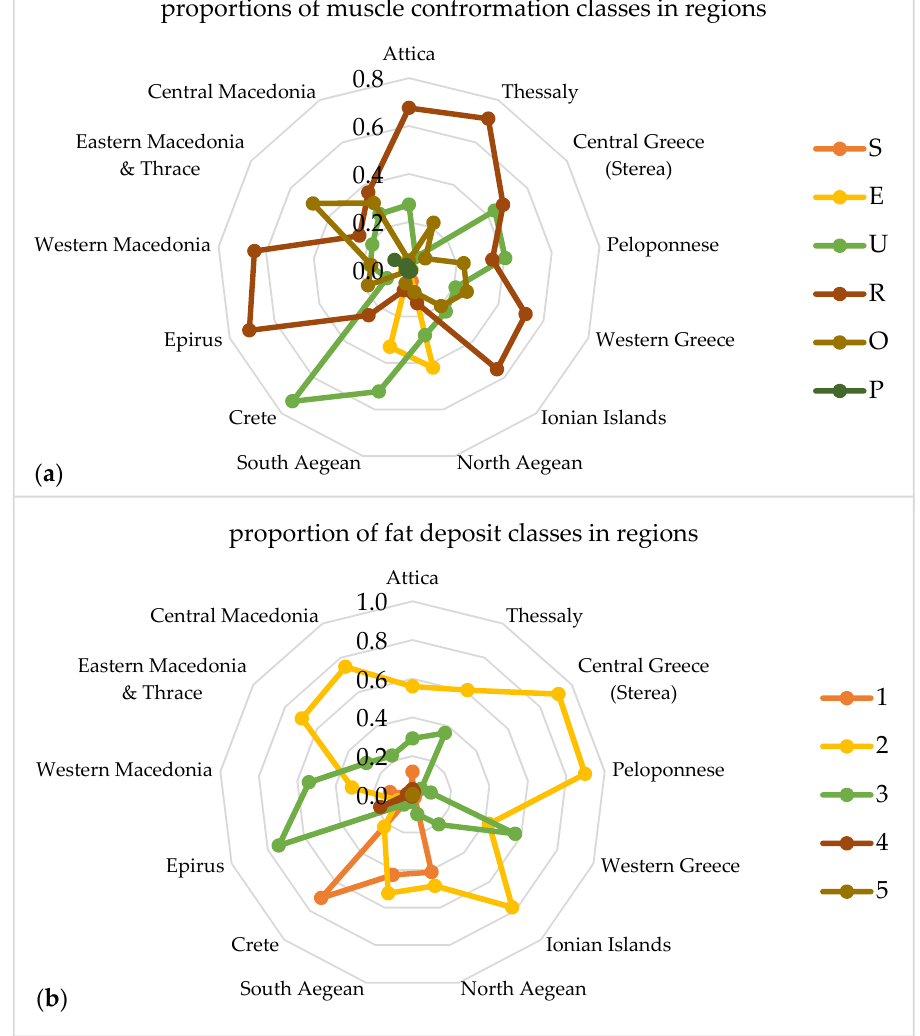
Figure 3. Proportions of muscle conformation ( a ) and fat deposit ( b ) classes distributed across 13 regions.